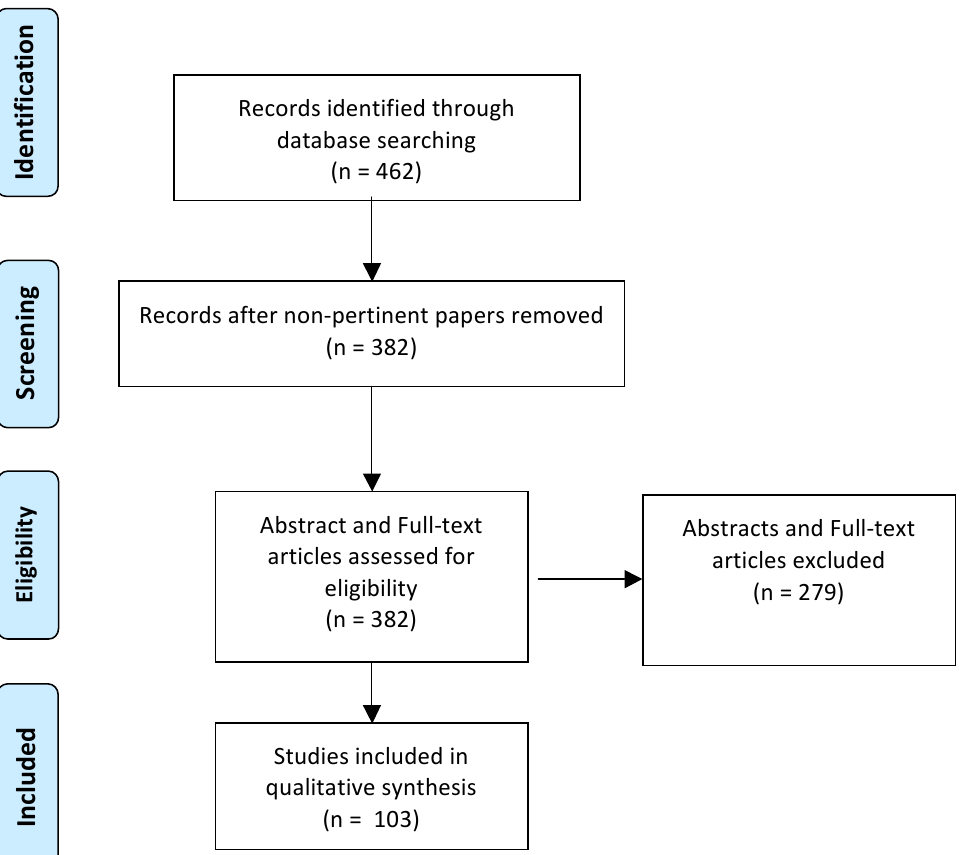
Figure 1. Flowchart according to the PRISMA criteria .